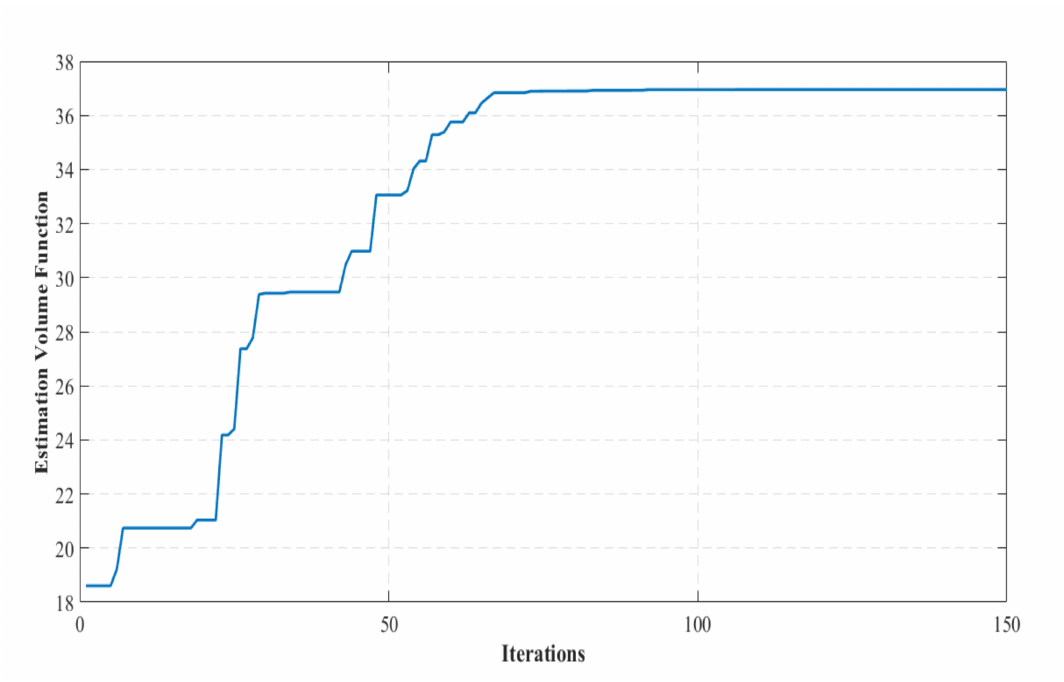
Figure 7. Evolution of Ω ( G ) using CPSO method for the three-dimension